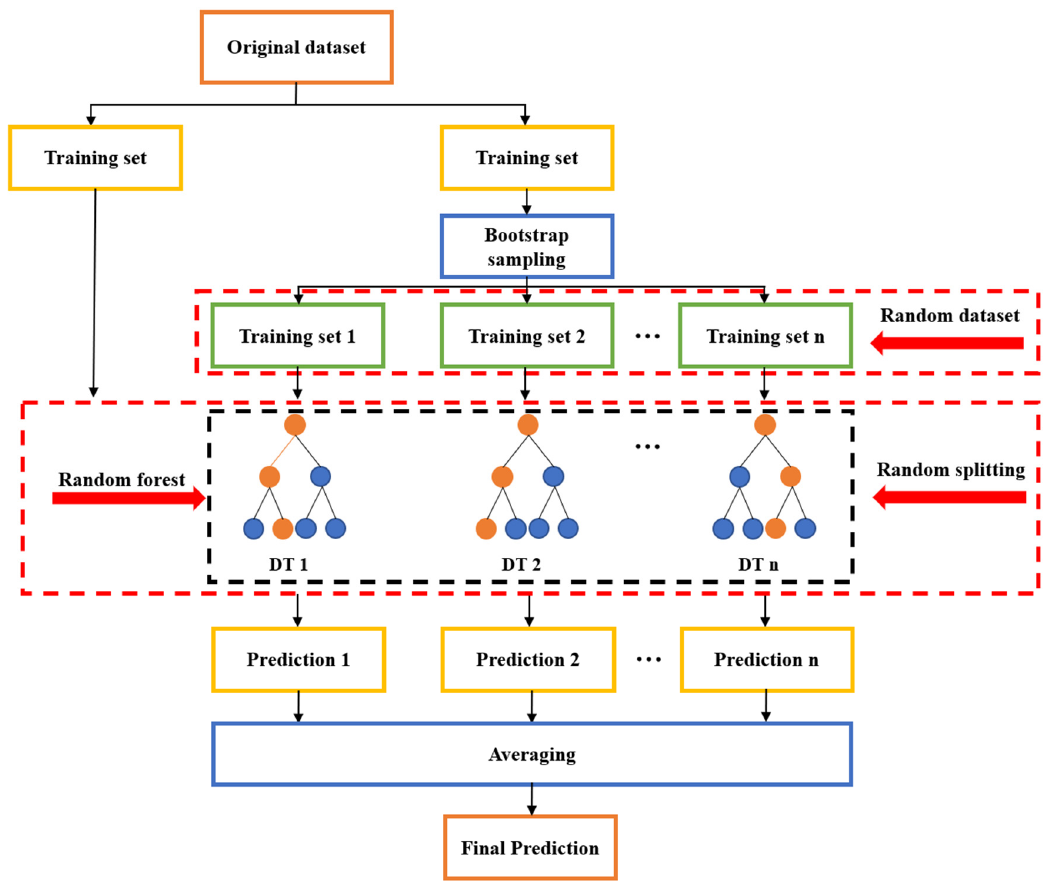
Figure 6. Construction of RF.